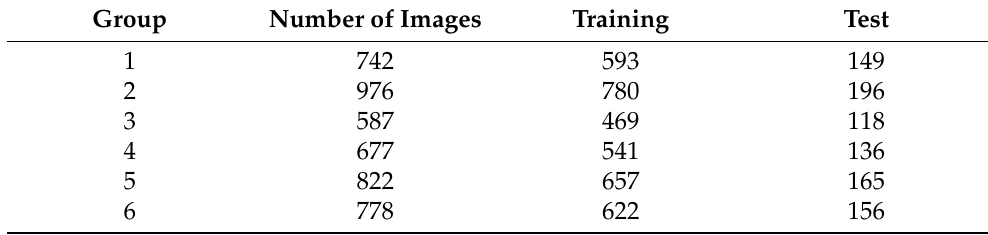
Table 1. Number of